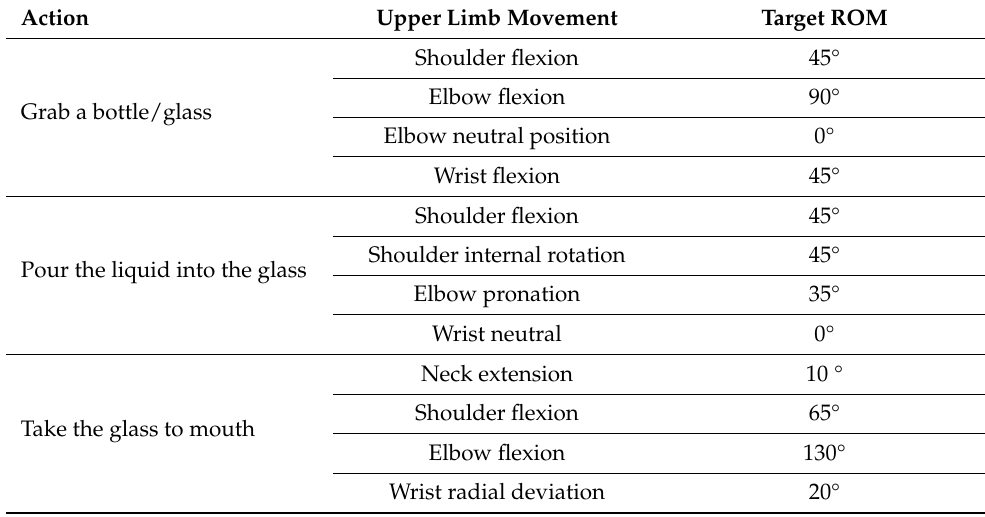
Table 2. Sequence of actions and the upper limb movements involved in the pouring a drink activity. Action